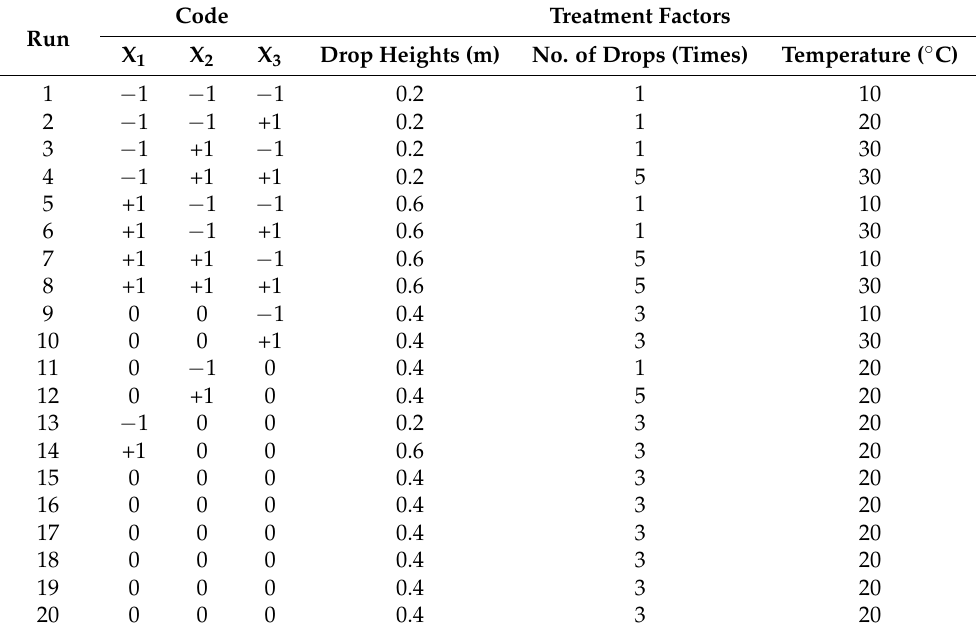
Table 4. RSM with central composite face-centered design (CCF) to optimize simulated impact conditions of ‘Glom Sali’